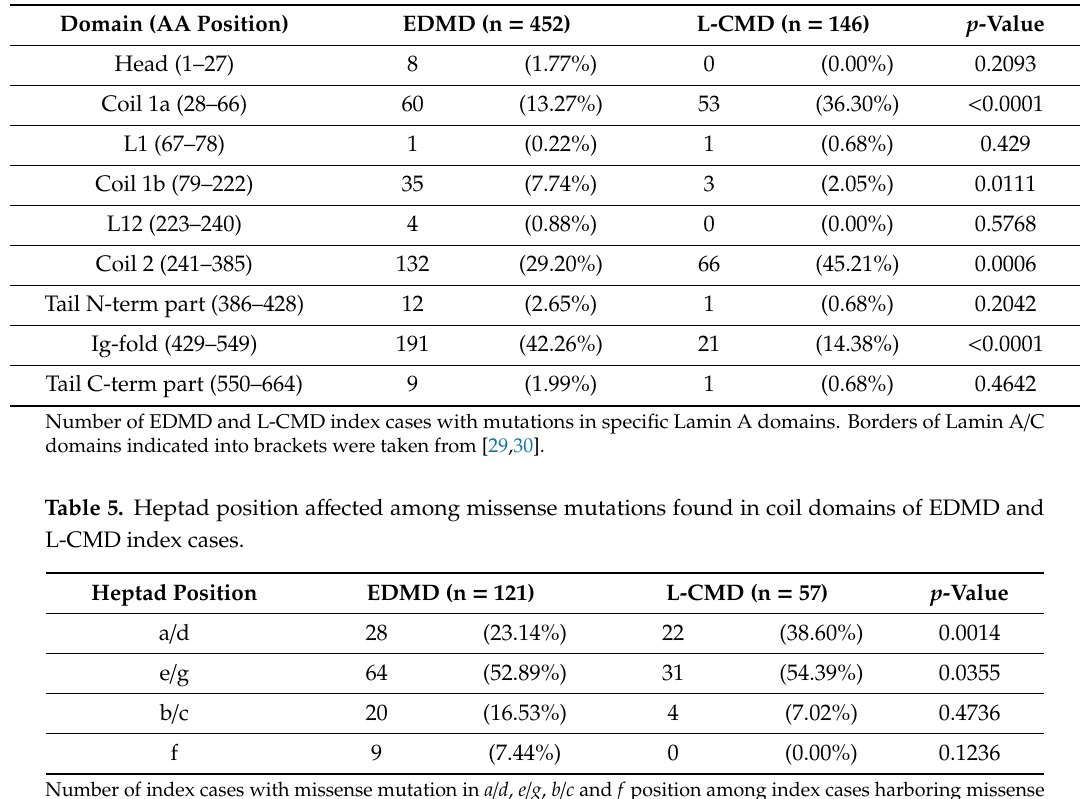
Table 4. Localization of mutations within Lamin A domains among EDMD and L-CMD index cases.